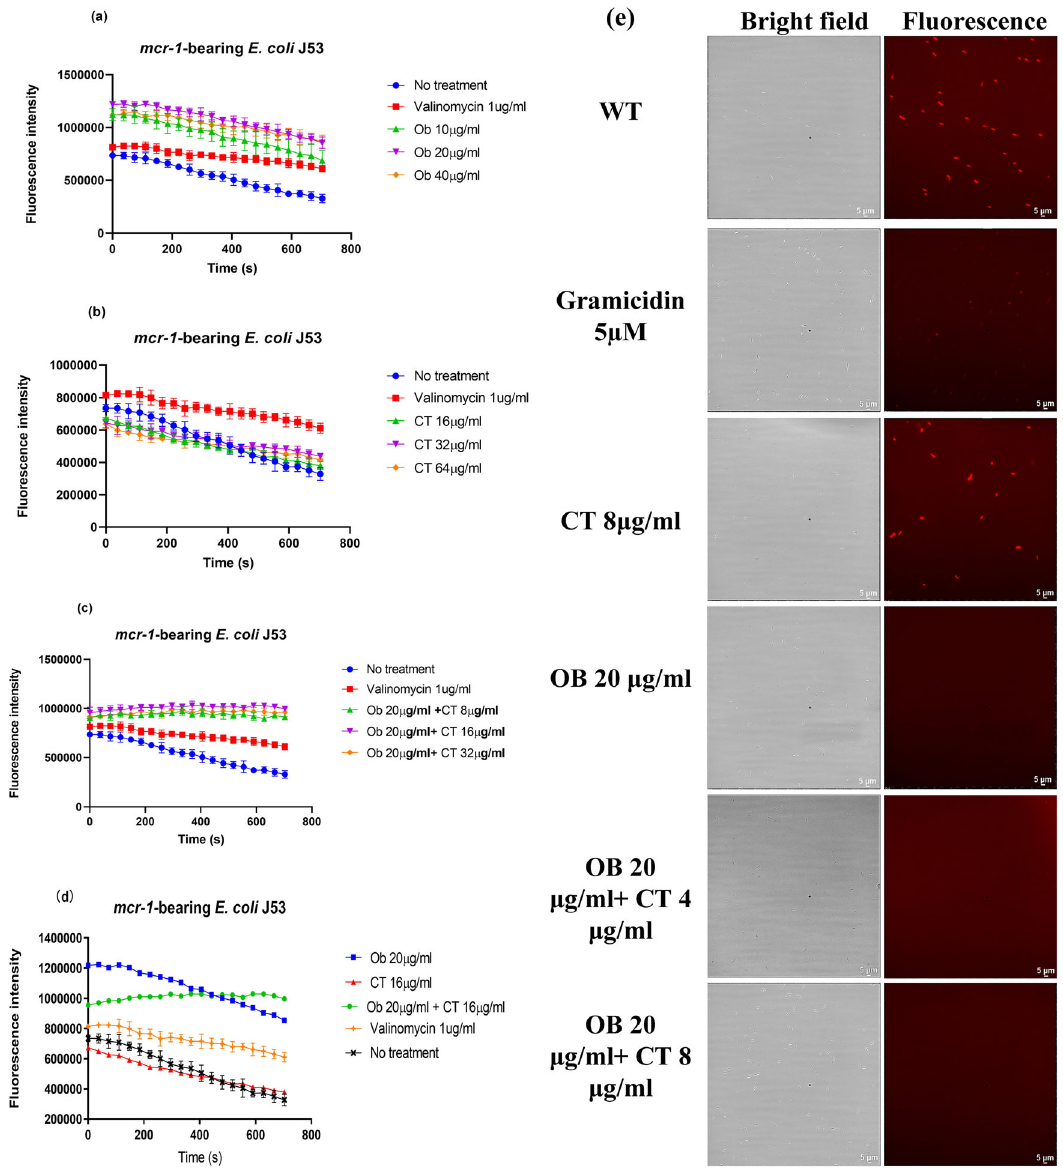
Fig. 7 Ob dissipates the bacterial membrane potential. Dissipation of membrane potential in mcr-1 -bearing E. coli J53 upon treatment with Ob ( a ), colistin ( b ), and various combinations of the two drugs ( c ). d Comparison of effects of different compounds on the bacterial cell membrane potential of mcr-1 - bearing E. coli J53. Valinomycin, a K + ionophore, was used as positive control. The assay was conducted in the presence of 100 mM of KCl. CT, colistin. e Fluorescence microscopic images of bacterial membrane potential of mcr-1 -bearing E. coli J53 taken upon treatment with Ob and colistin. Gramicidin, an ionophore, was used as the positive control. Data are mean ± SEM for n = 3 biologically independent